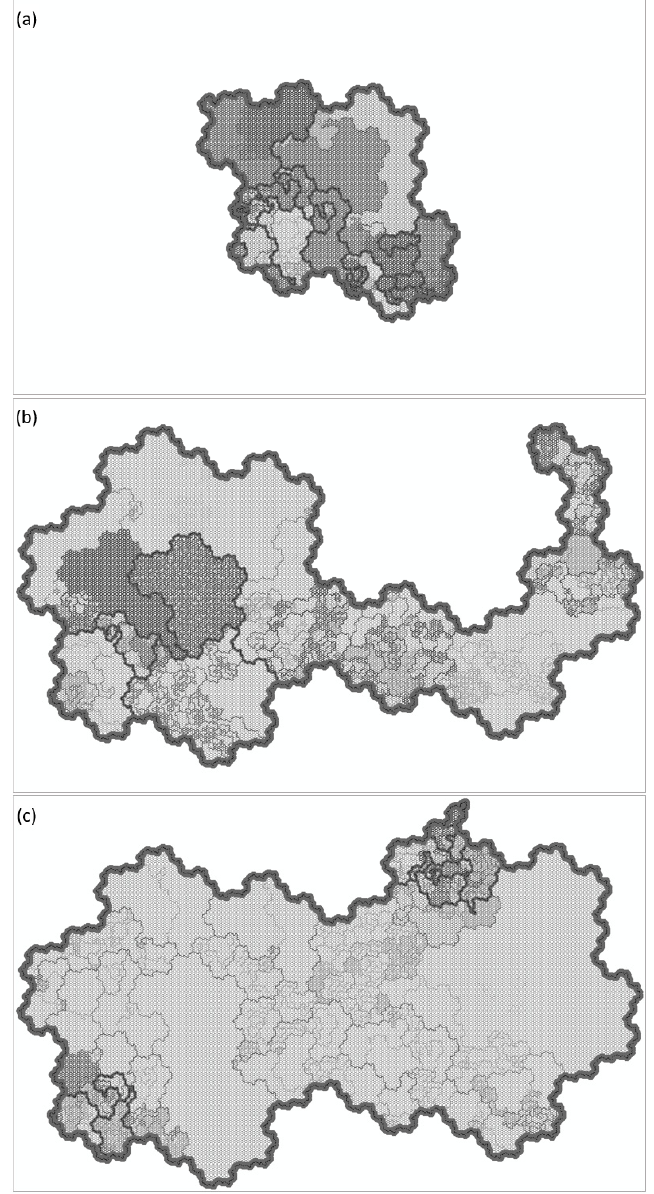
Figure 8. The polygon map frames of different data sources: ( a ) for ArcGIS Desktop 10.1; ( b ) for MyEclipse 2017; ( c ) for Visual Studio 2015.